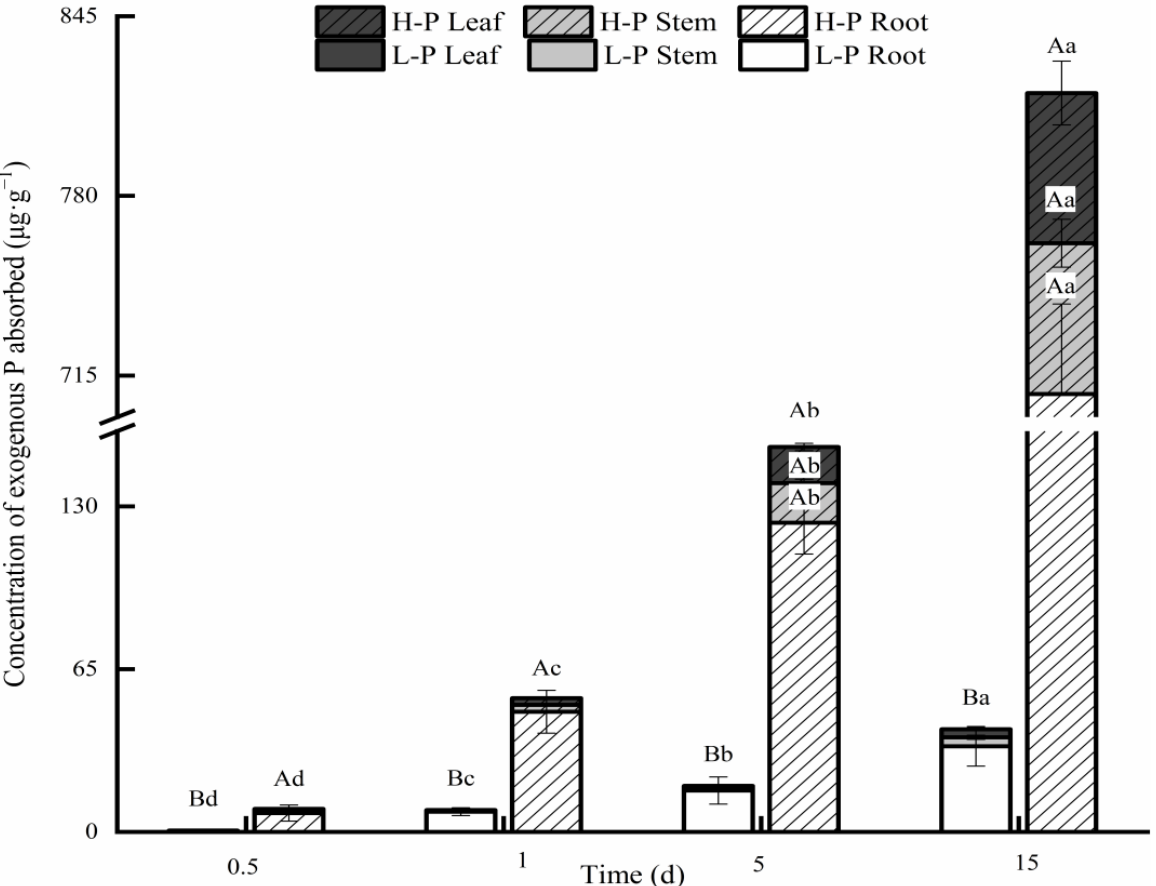
Figure 2. The concentration of exogenous P in different organs of M1 Chinese fir under different P supply conditions. “L-P” and “H-P” represent the low-P and high-P treatments, respectively. Error bars represent standard error, and each point in the figures represents the mean of the five replicates ( n = 5). Lowercase letters indicate significant differences ( p < 0.05) at different treatment times under the same P treatment. Uppercase letters indicate significant differences ( p < 0.05) between treatments at each time point. Labeling conventions are the same across time points.